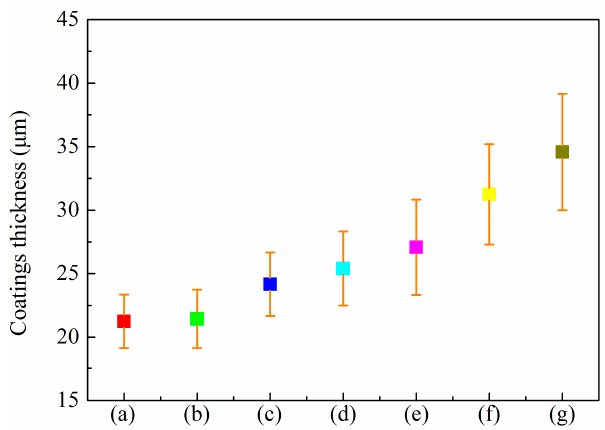
Figure 6. The thickness of microarc oxidation coatings formed on aluminum alloys at different anode pulse-widths. (a): 1000 μ s; (b): 1500 μ s; (c): 2000 μ s; (d): 2500 μ s; (e): 3000 μ s; (f): 3500 μ s; (g): 4000 μ s. The surface morphologies of the microarc oxidation self-lubricating composite coatings are shown in Figure 7. The micropores and microcracks on the surface of the MAO ceramic coatings were filled with the FEP dispersion.